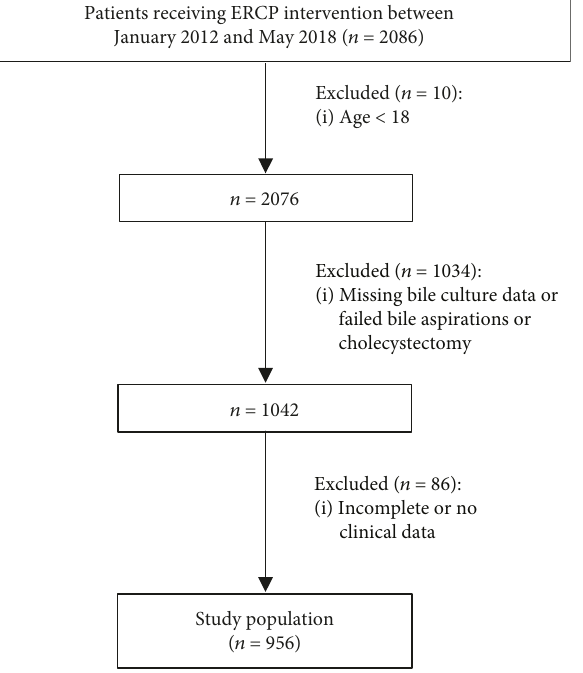
Figure 1: Patient selection fl ow